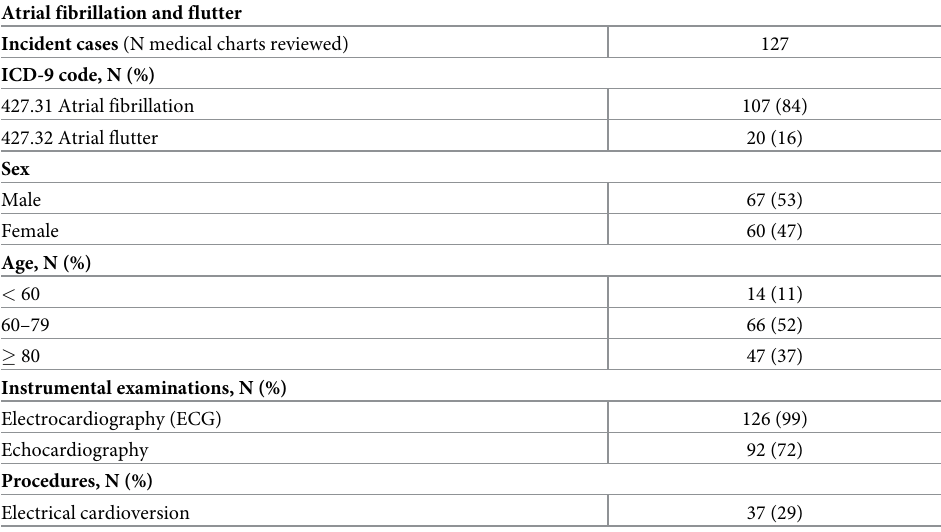
Table 2. Characteristics of patients with atrial fibrillation and flutter who were identified in the Regional Admin- istrative Database of Umbria. Atrial fibrillation and